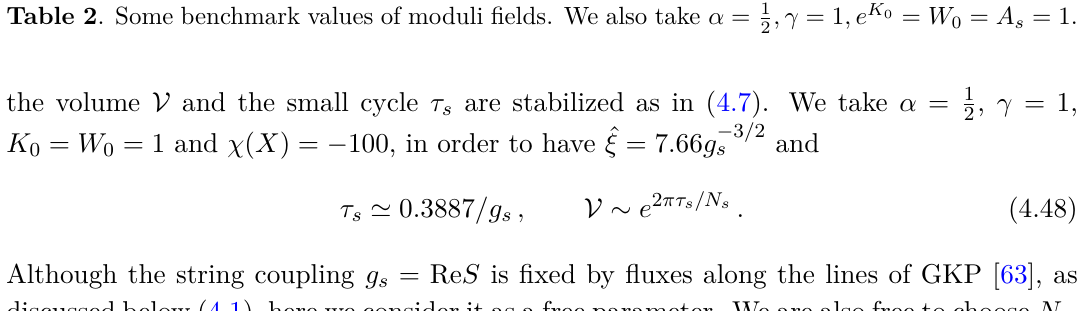
are stabilized as in (4.7). We take α = 1 s